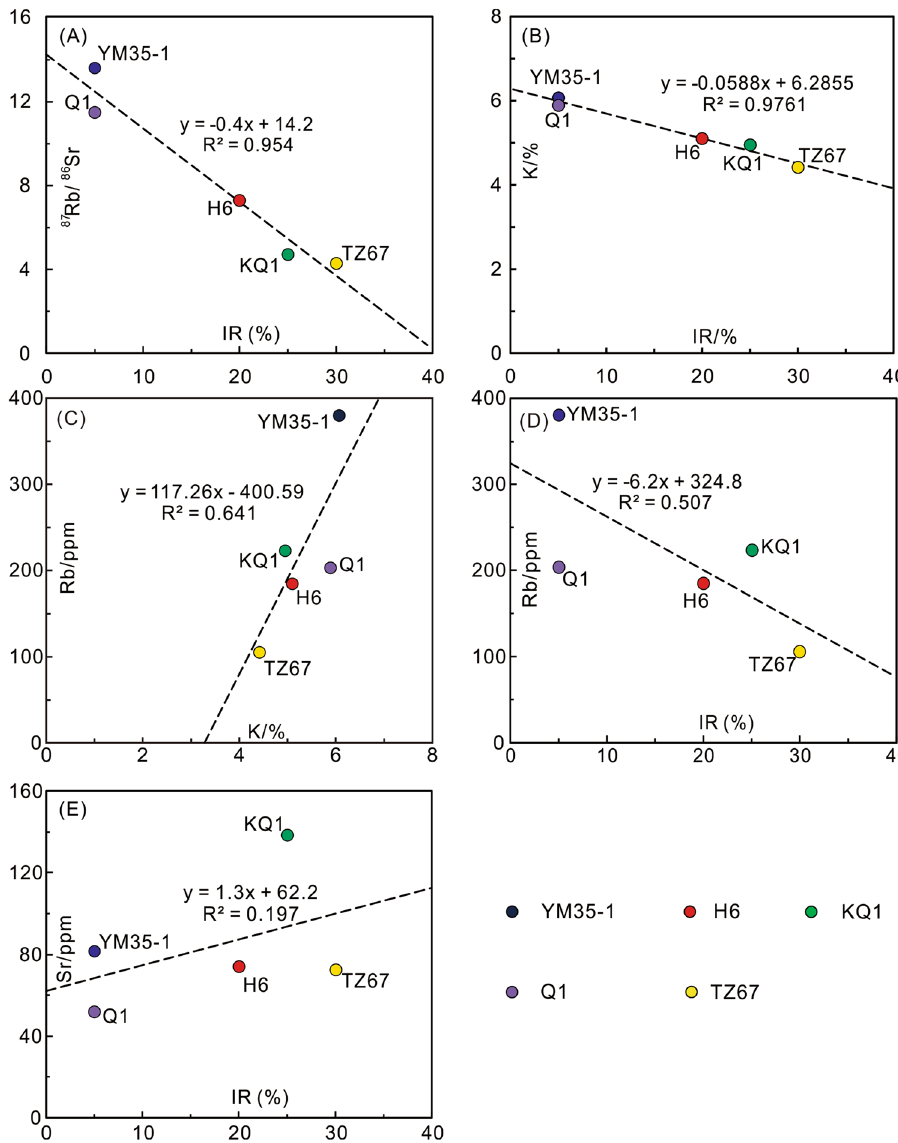
( A ) 87 Rb/ 86 Sr vs interstratified ratio (IR) of I/S. IR is the percentage of smectite layers in I/S; ( B ) potassium (K) content vs IR of I/S; ( C ) Rb content vs K content; ( D ) Rb content vs IR of I/S; ( E ) Sr content vs IR of